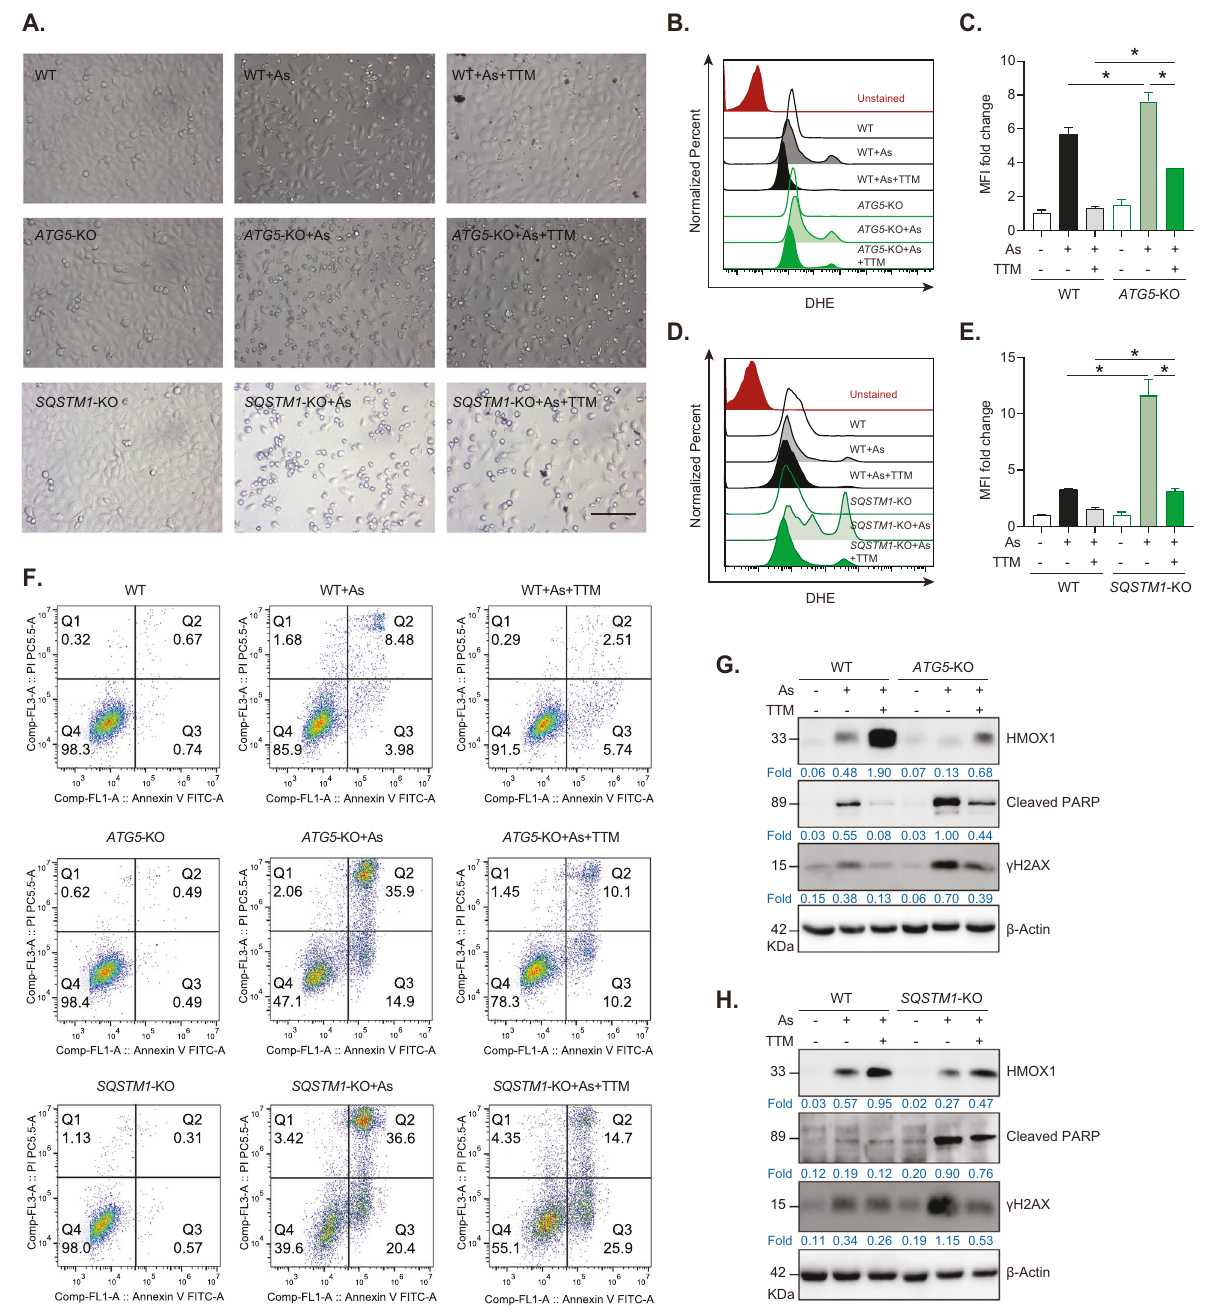
Fig. 6 Autophagy-dependent activation of NRF2 protects HUVECs from NaAsO 2 -induced cytotoxicity. A Representative morphological changes of WT control, ATG5 -KO or SQSTM1 -KO cells treated with 30 μ M NaAsO 2 with or without 100 μ M TTM for 24 h, respectively. Scale bar, 100 μ m. B , C FACS analysis and quanti fi cation of DHE intensity in WT control or ATG5 -KO cells treated with 30 μ M NaAsO 2 with or without 100 μ M TTM for 12 h. D , E FACS analysis and quanti fi cation of DHE intensity in WT control or SQSTM1 -KO cells treated with 30 μ M NaAsO 2 with or without 100 μ M TTM for 12 h. In C and E , MFI mean fl uorescence intensity. One-way ANOVA followed by a Tukey multiple comparison test was used for statistical analysis. * p < 0.05. F FACS analysis of apoptotic cell death in WT control, ATG5 -KO and SQSTM1 -KO cells treated with 30 μ M NaAsO 2 with or without 100 μ M TTM for 24 h. G Western blot analysis and quanti fi cation of HMOX1, cleaved PARP, γ H2AX, and β -Actin in WT and ATG5 -KO cells treated with NaAsO 2 with or without TTM. H Western blot analysis and quanti fi cation of HMOX1, cleaved PARP, γ H2AX and β -Actin in WT control or SQSTM1 -KO cells treated with NaAsO 2 with or without TTM. Inorganic arsenic (NaAsO 2 ) is a class of environmental pollutants proteasome pathway and accelerates proteasomal degradation of NRF2 [24, 53]. Therefore, we speculate that autophagy and mainly derived from coal burning, non-ferrous metals production, and SQSTM1 contribute to TTM-mediated NRF2 activation via polluted water [54]. It has been demonstrated that arsenic exposure is simultaneously inducing the release of NRF2 from the KEAP1- signi fi cantly associated with an increased risk of cardiovascular NRF2 complex and preventing NRF2 degradation in proteasome disease and coronary heart disease [55]. Arsenic is also used as in HUVECs. oxidative stress inducer to induce excessive ROS production and Cell Death and Disease (2022)